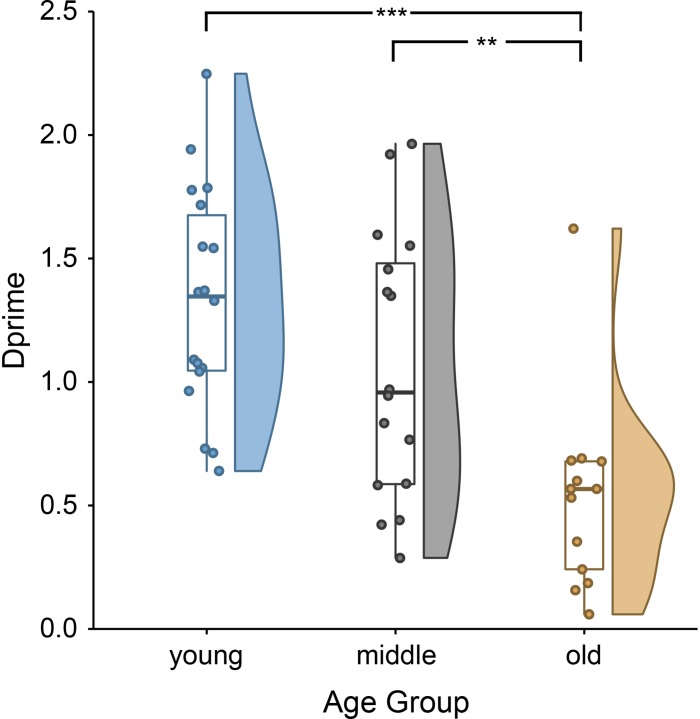
Lower sentence comprehension accuracy, indirectly indicating lower encoding success, for older than younger and middle-aged adults: single subject means (scatter points), group medians (line within boxes), as well as probability density of d-prime values of younger, middle-aged and older adults (for more information on raincloud plots, see Allen et al., 2019). ∗∗∗p < 0.001 and ∗∗p < 0.01.